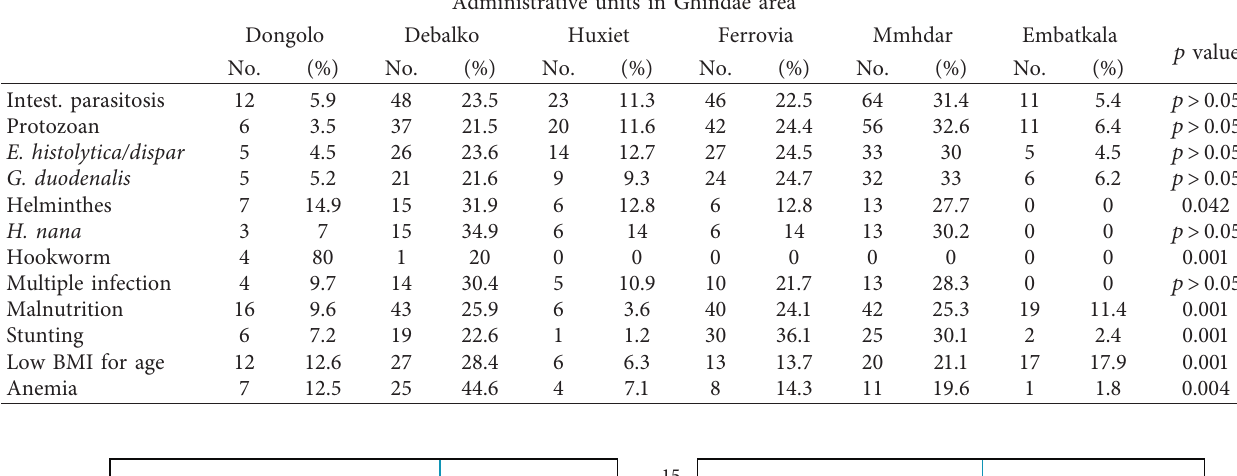
Table 2: Distribution of intestinal parasitosis, malnutrition, and anemia among the six administrative units in Ghindae area, Eritrea, 2018 ( n � 450).